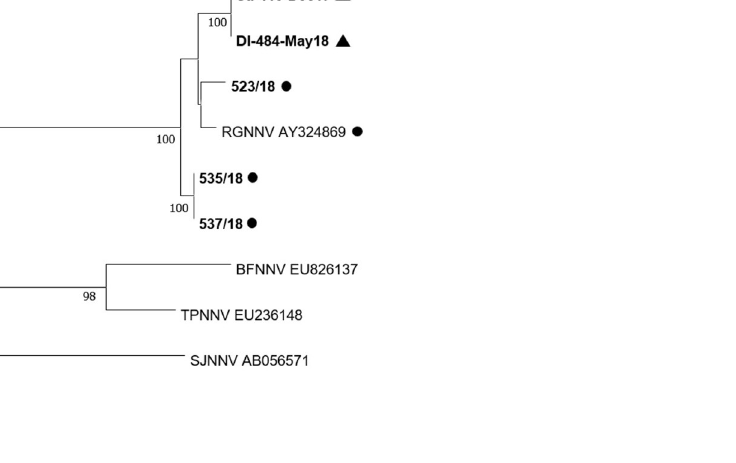
Fig 5. Phylogenetic tree based on RNA1 sequences. Phylogenetic tree based on RNA1 nucleotide sequences. Reference strains are reported with genotype name and accession number. All sequences of tested samples (bold) including parental RGNNV (dot) and RGNNV/SJNNV reassortant strains (triangle) clustered within the RGNNV group. Bootstrap values > 70% are shown. Branch lengths are scaled according to the number of nucleotide substitutions per site. The scale bar is